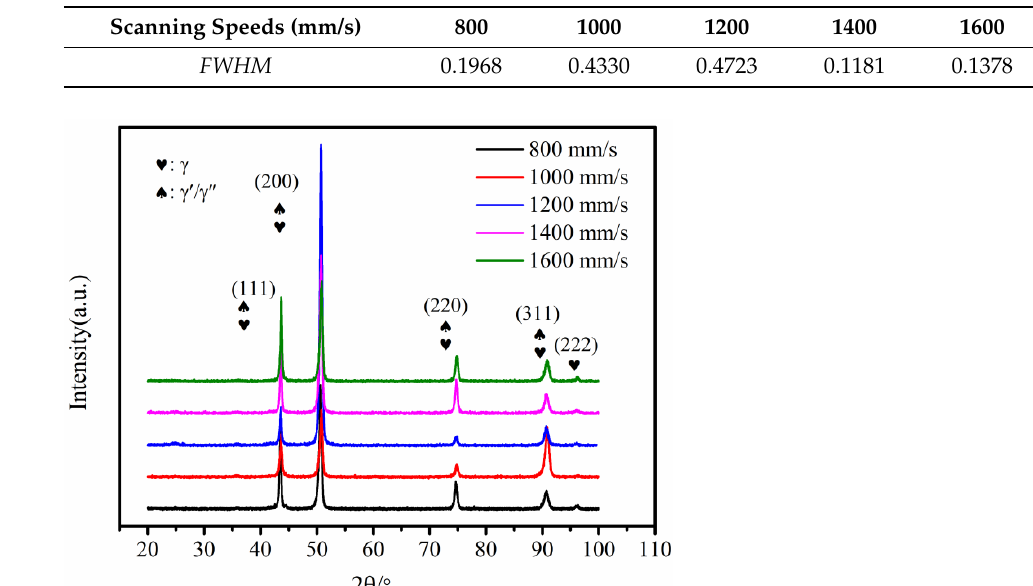
Figure 2. XRD analysis of K418 samples prepared at different scanning speeds.